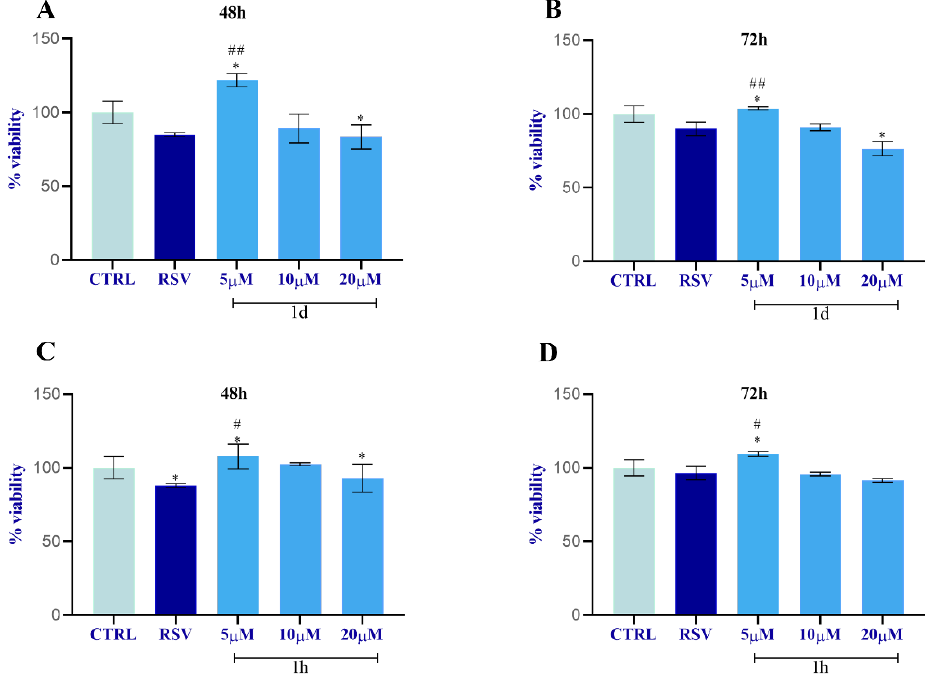
Figure 5. HGFs viability percentage after treatment with 1d ( A , B ) and 1h ( C , D ). Data were calculated as means ± SD and compared to CTRL (cells treated with 0.1% DMSO); RSV: cells treated with 10 µM of RSV. * Significance in respect to CTRL: * p < 0.05; # Significance in respect to RSV and 1d and 1h : # p < 0.05; ## p < 0.001.